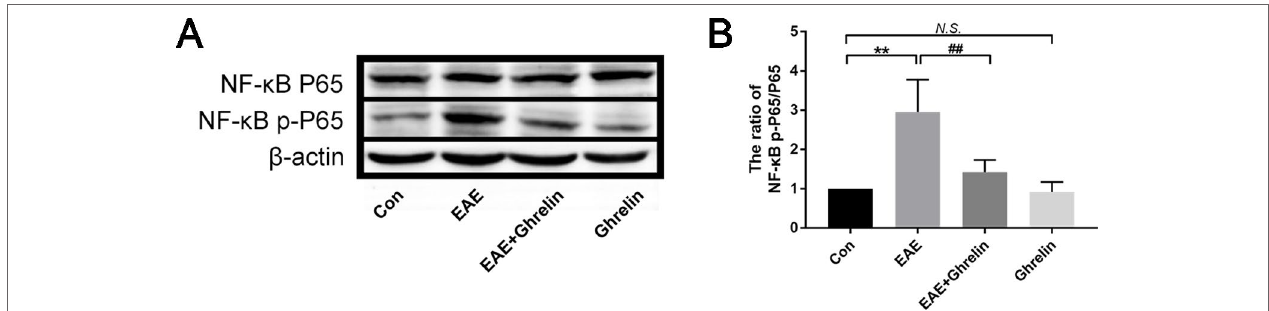
FIGURE 7 | Treatment of ghrelin inhibited NF-κB activation in EAE rats. (A) Representative western blot images of changes in the expression level of NF-κBP65 and NF-κB p-P65. (B) The ratio of NF-κB p-P65/NF-κBP65. Data were shown as mean ± SD ( n = 5).** P 0.01 versus the control group, ## P 0.01 versus the EAE group. NS , not significant. Con,